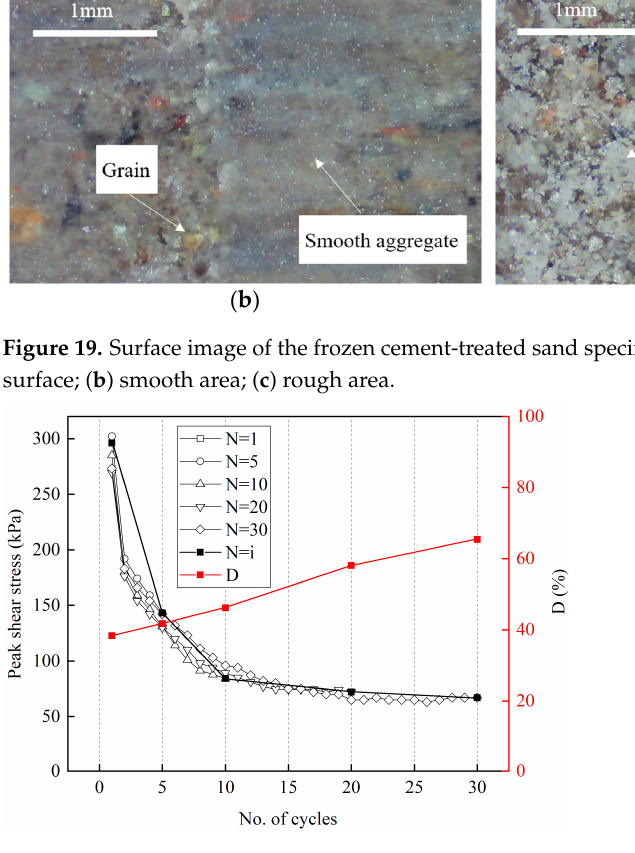
Figure 20. Variation of the peak shear stress and smoothness for the different number of